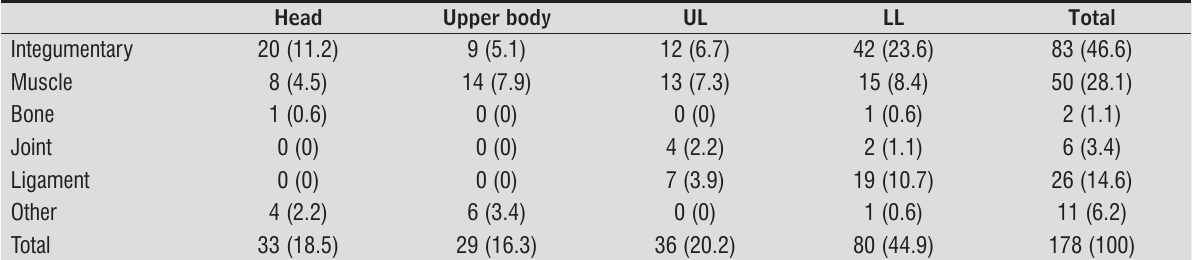
Table 3 - bsolute and relative distribution of type of lesion by anatomical region of